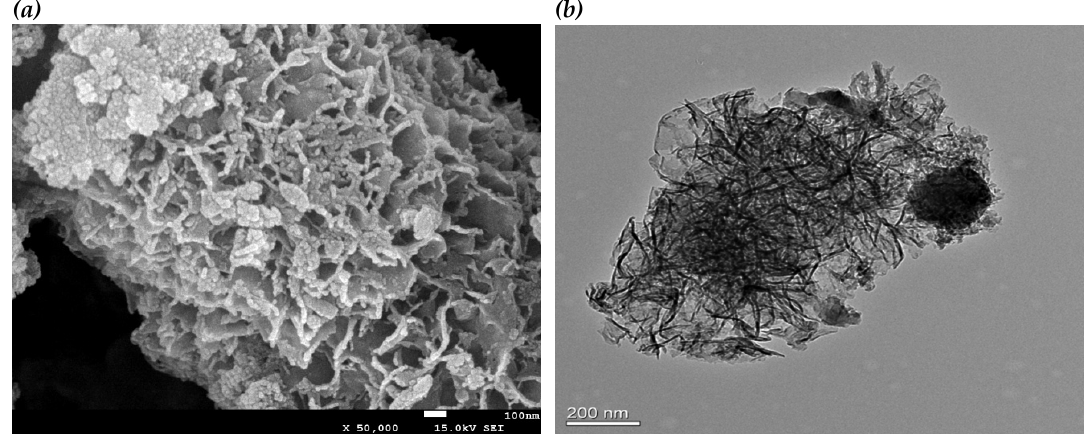
Figure 1. ( a ) Scanning electron microscopy (SEM) image of Mn 0.1 Cu 0.9 -MOF. ( b ) Transmission electron microscopy (TEM) image of Mn 0.1 Cu 0.9 -MOF.